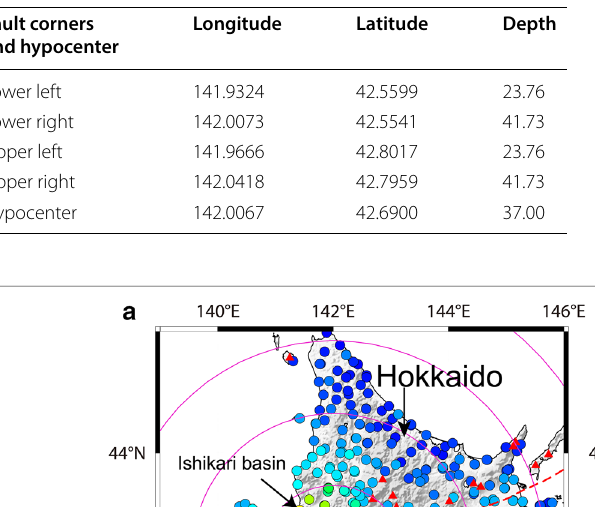
Table 1 Coordinates of the four corners of the fault plane estimated in the present study and the hypocenter determined by JMA Fault corners and hypocenter